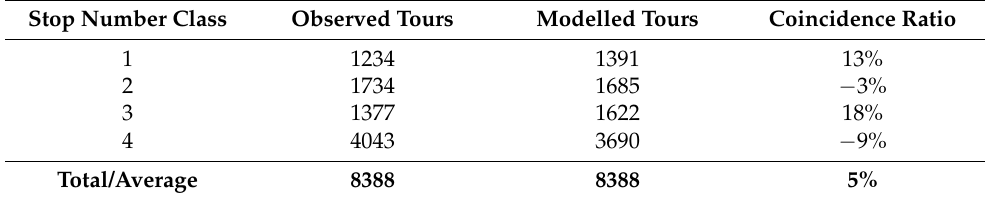
Figure 5. Model validation: observed vs. modelled tours. Table 2. Coincidence ratio between observed and predicted distributions of the number of stops and distance.